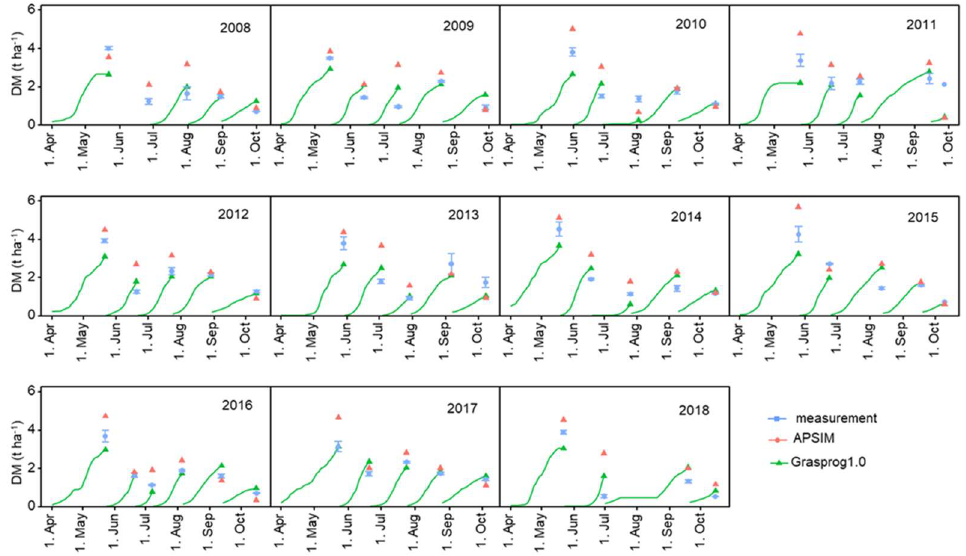
Figure 8. Measured grass dry matter (DM) for different cuts and years for Schuby, Germany. The predictions by GrasProg1.0 and APSIM are also shown.